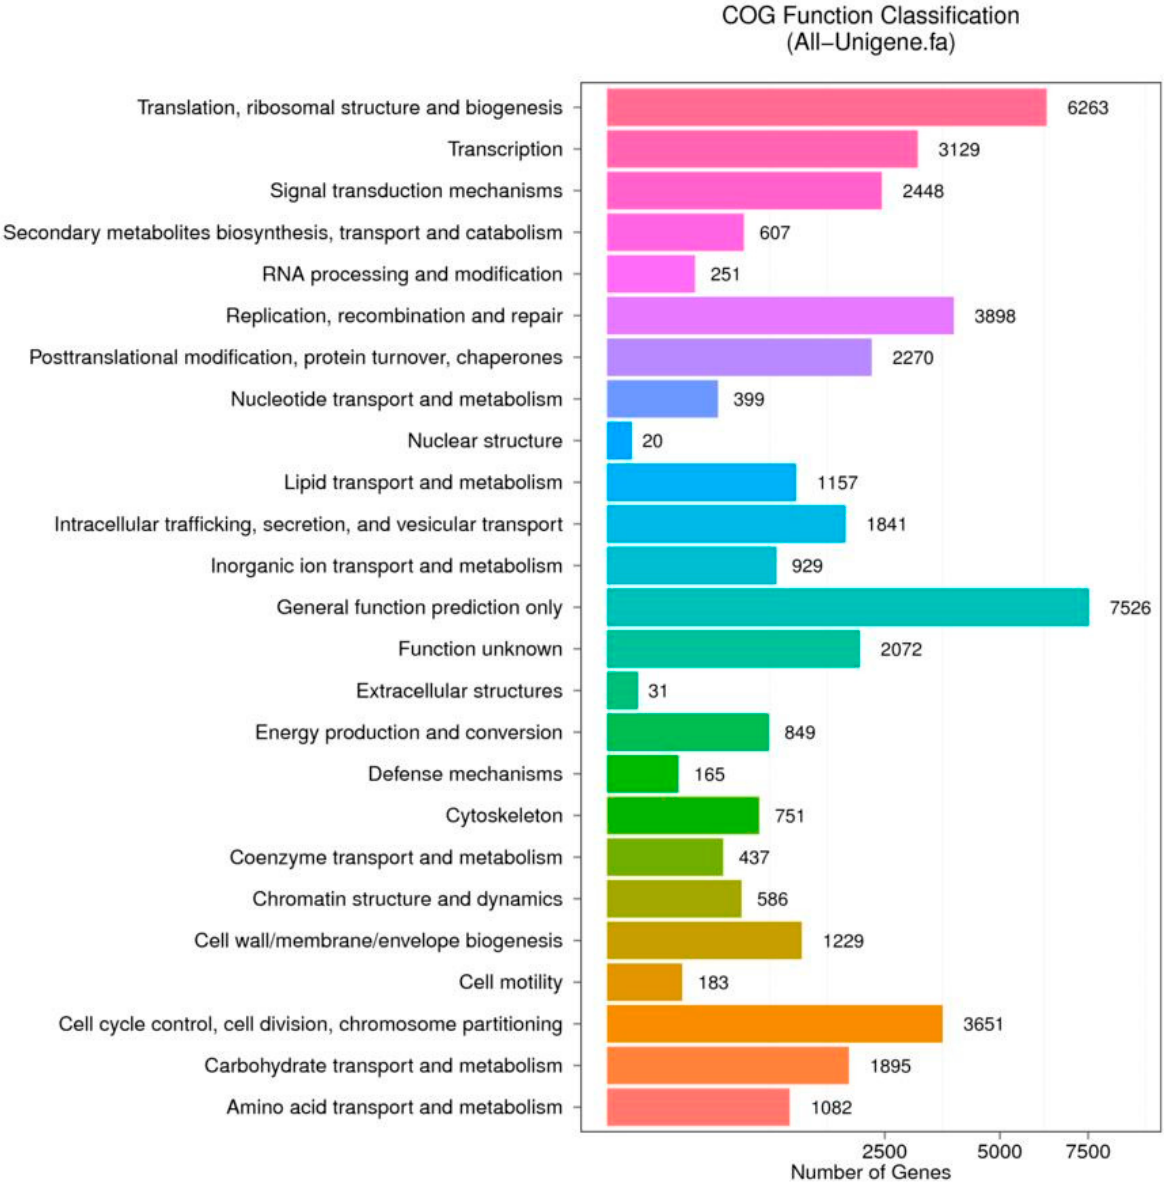
Figure 2. COG classifications of consensus sequences. COG categories are shown on the vertical axis and the numbers of genes are plotted on the horizontal axis.